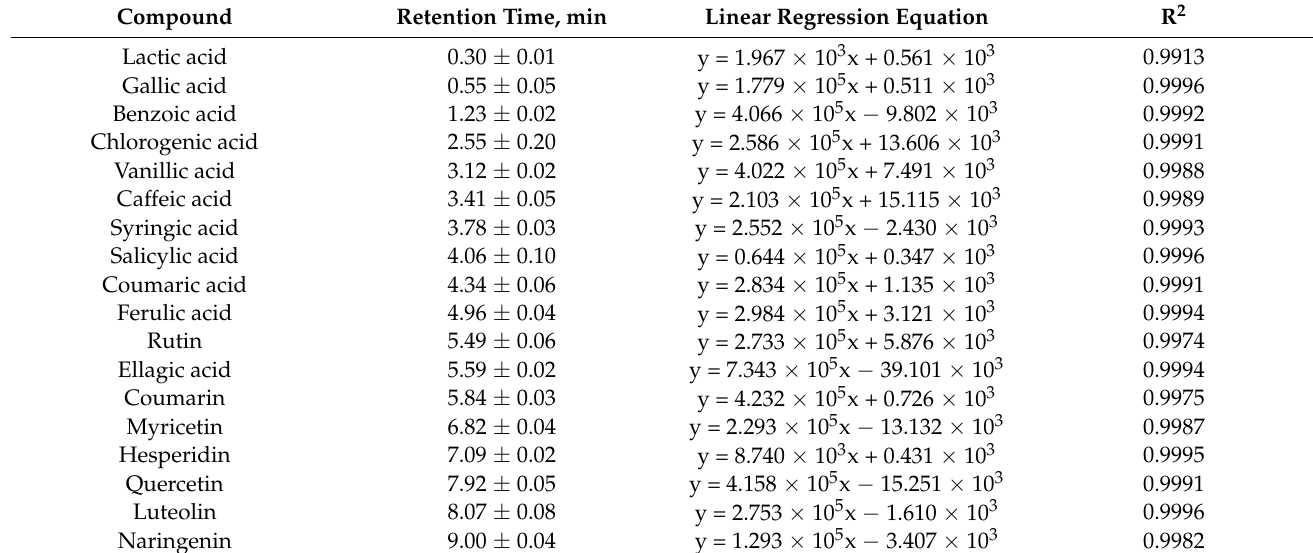
Table 3. Calibration curve data for the reference compounds (n =